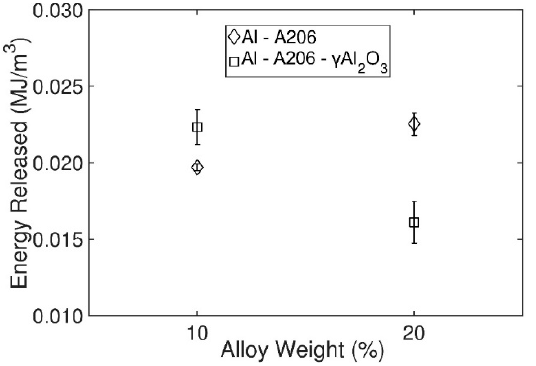
Figure 16. Energy released during the PLC phenomenon at a 0.250 mm/min strain rate.